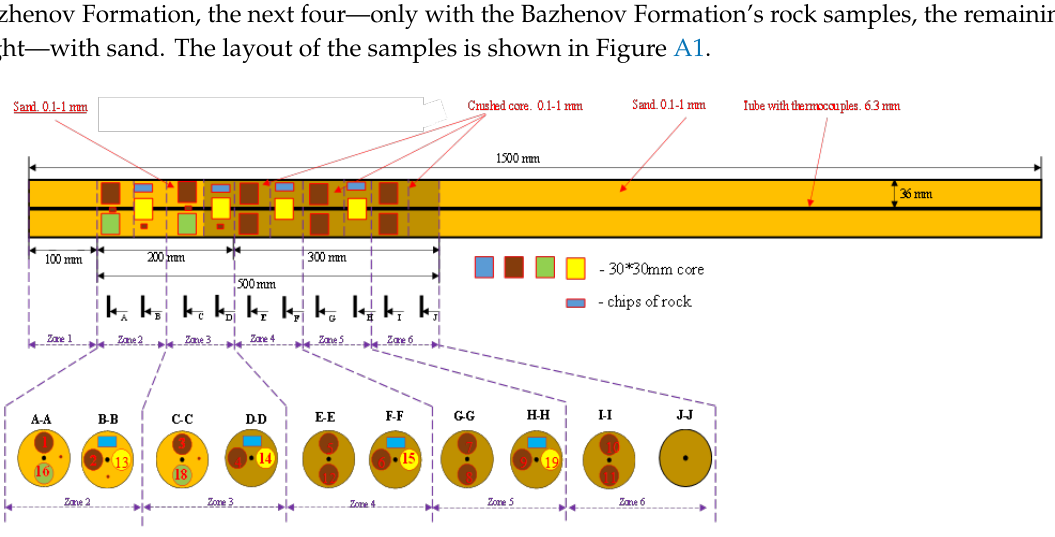
FigureA1. Locationoftheanalyzedsamplesinthecombustiontube(Modifiedafter[37]). Zone numeration corresponds to the CT section